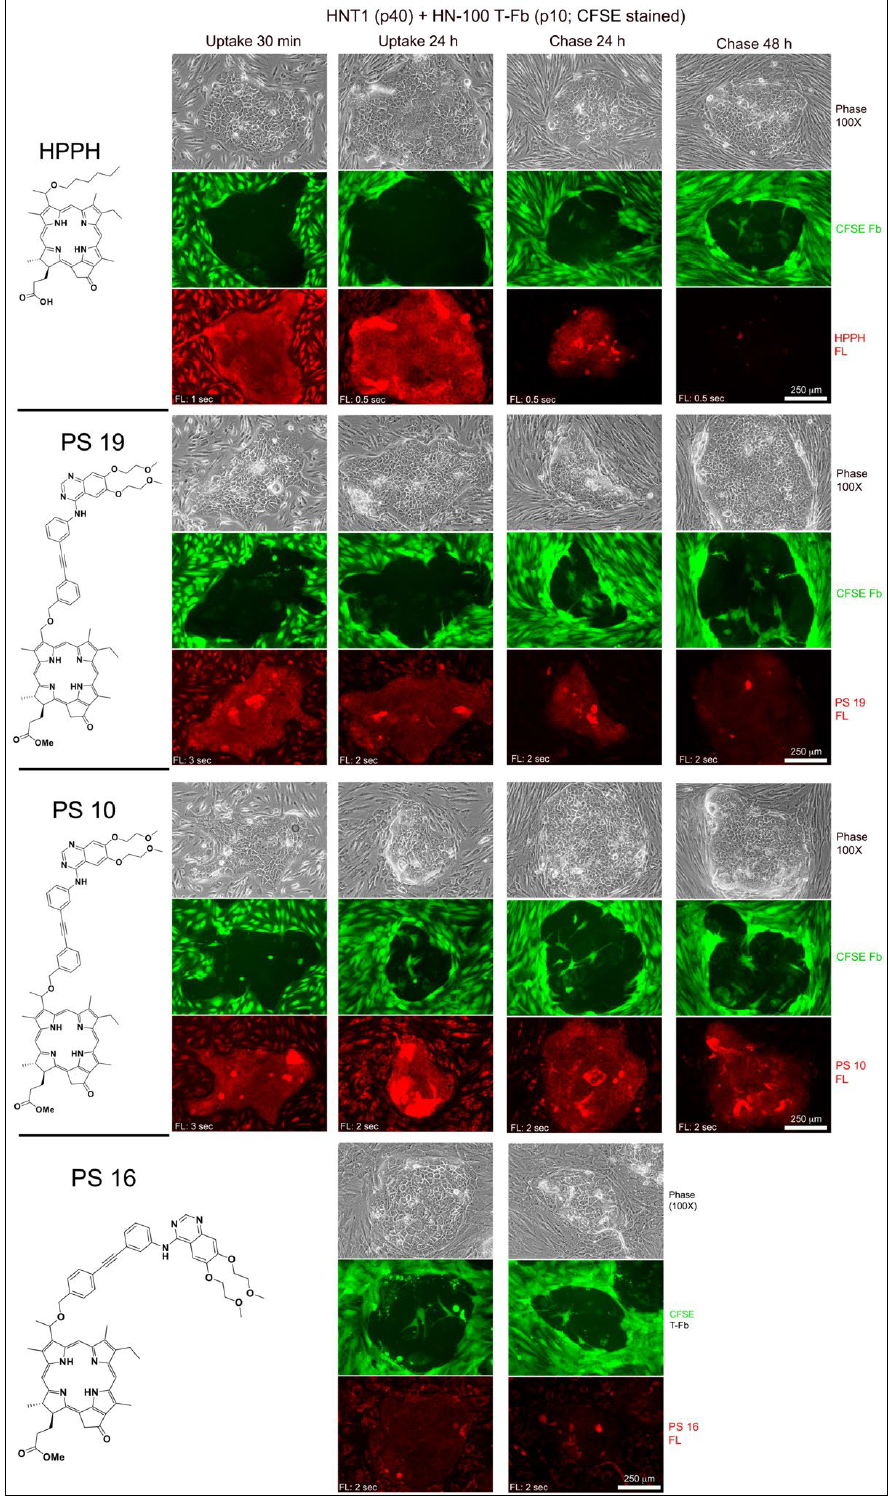
Figure 2. Uptake and retention kinetics for HPPH, PS 19, PS 10, and PS 16 in co-culture of HNT1 and CFSE-stained HN-T-Fb. Three-day old co-cultures of HNT1 (p 40) and CFSE-stained HN-100 T-Fb (p 10) were incubated in DMEM containing 10% FBS and 3 µ M of the PS indicated at the left. Initial binding and uptake were determined after 30 min treatment at 37 ◦ C and maximal uptake after 24 h. Retention of the PSs was assessed after 24 and 48 h chase periods. Note, the difference in the length of exposure for PS